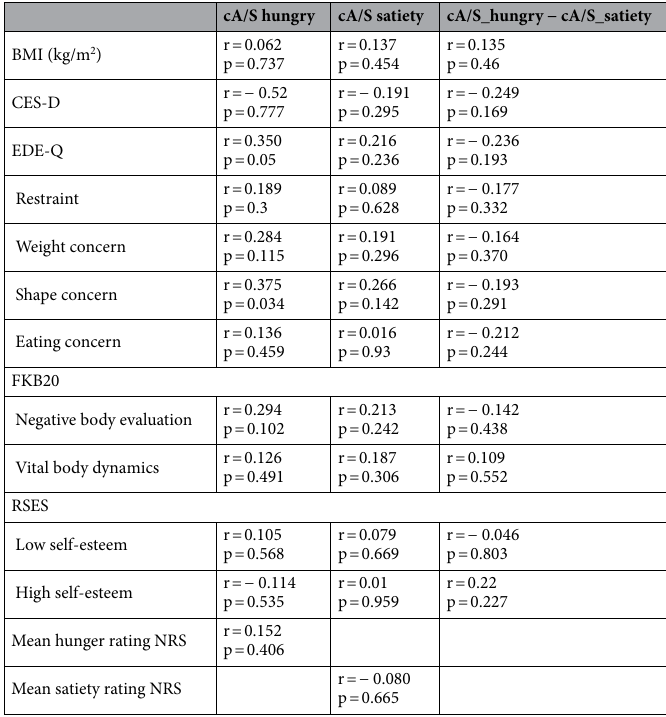
Table 1. Correlation between the cA/S values for hungry and satiety and the clinical characteristics. CES-D the Center for Epidemiological Studies Depression Scale 28 , EDE-Q Eating Disorder